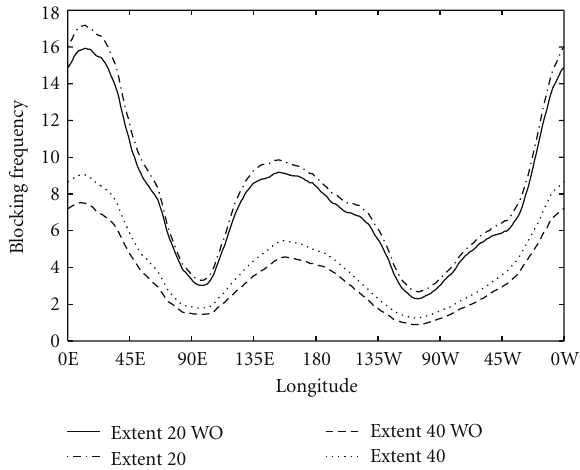
Figure 5: Extent filter and merging: Northern Hemisphere blocking frequency for the thresholds 21 . 375 ◦ and 41 . 625 ◦ compared to the case without merging (WO) as